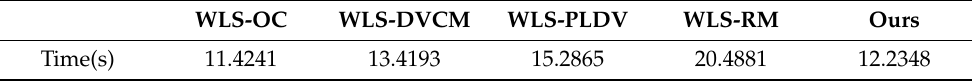
Table 3. Computational time of five algorithms for real scene (Figure